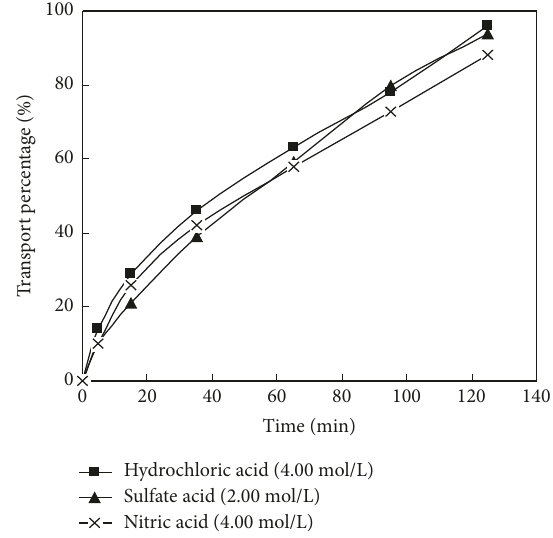
Figure 6: Effect of different stripping agents on transport of La(III).